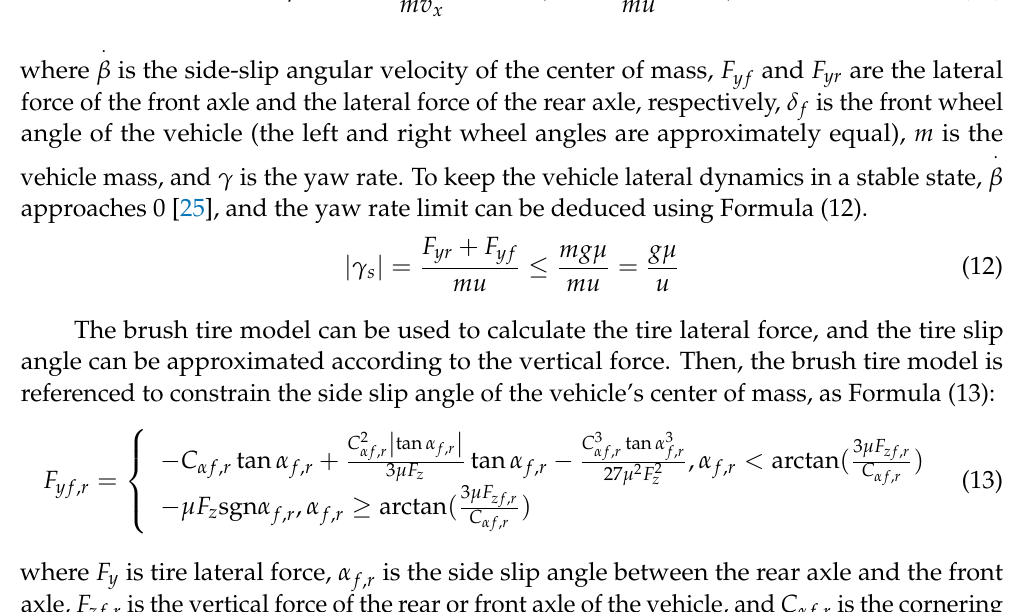
Figure 3. 2-DOF vehicle dynamic model.